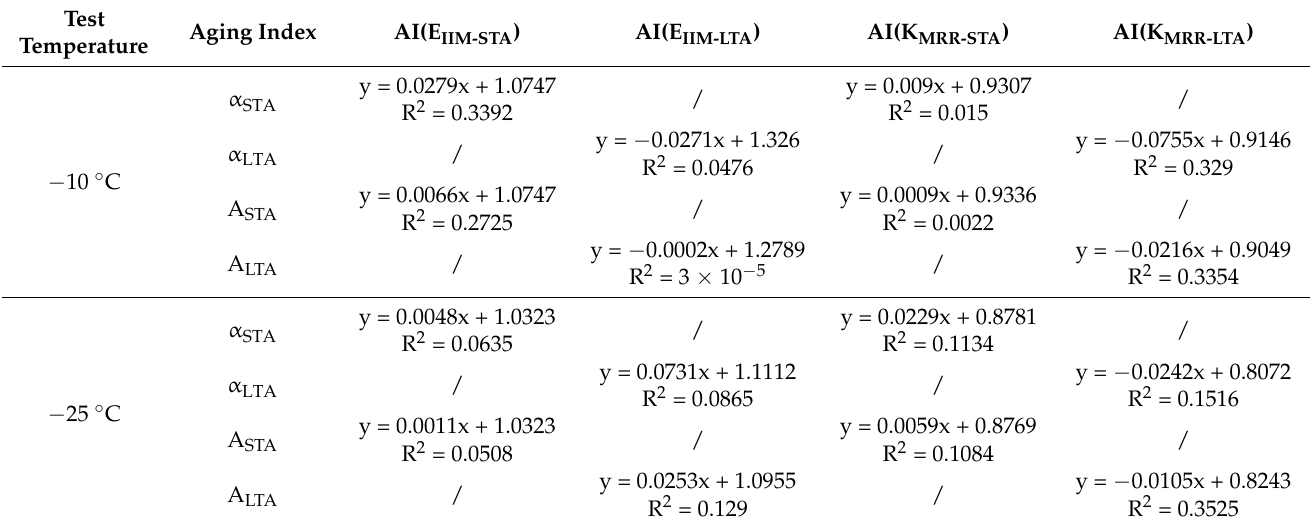
Table 14. Relationship between the rheological aging index and the relaxation ability.